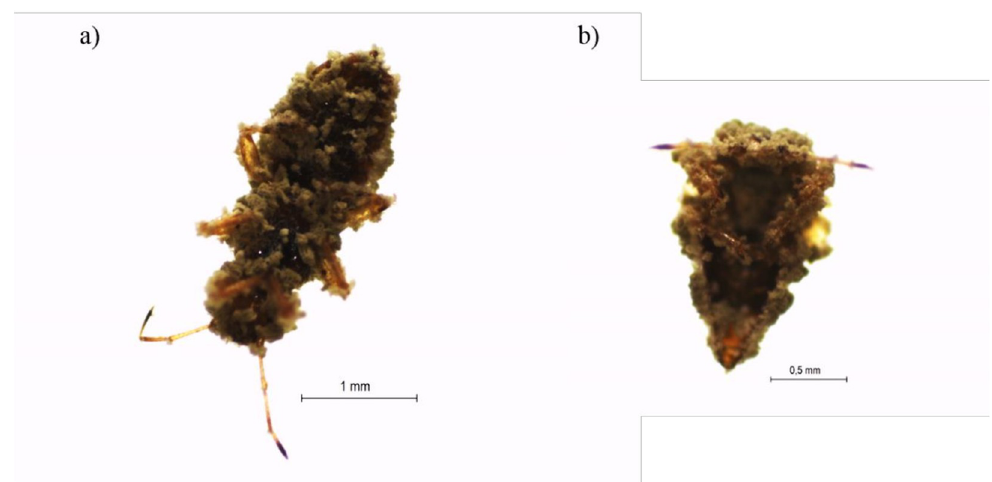
Fig 4. Adult (a) and third instar nymph (b) of Thaumastocoris peregrinus (Hemiptera: Thaumastocoridae) colonized by Metarhizium anisopliae .